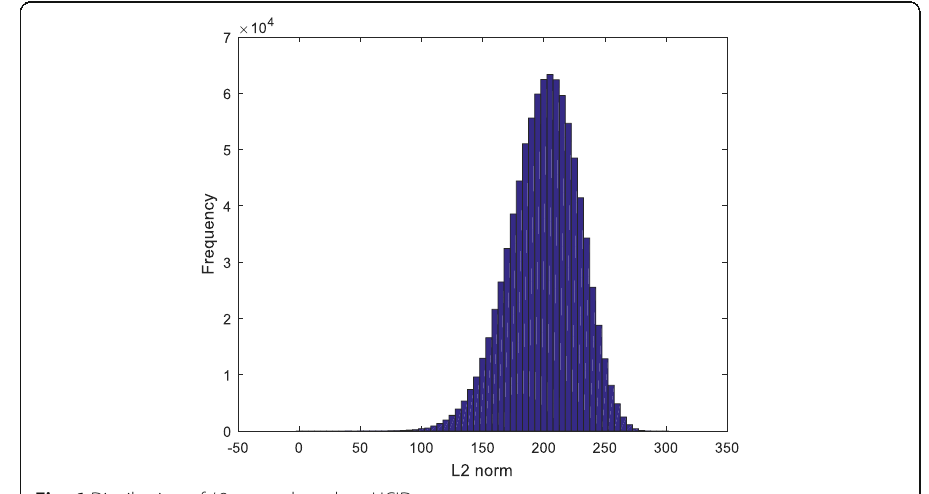
Fig. 6 Distribution of L 2 norms based on